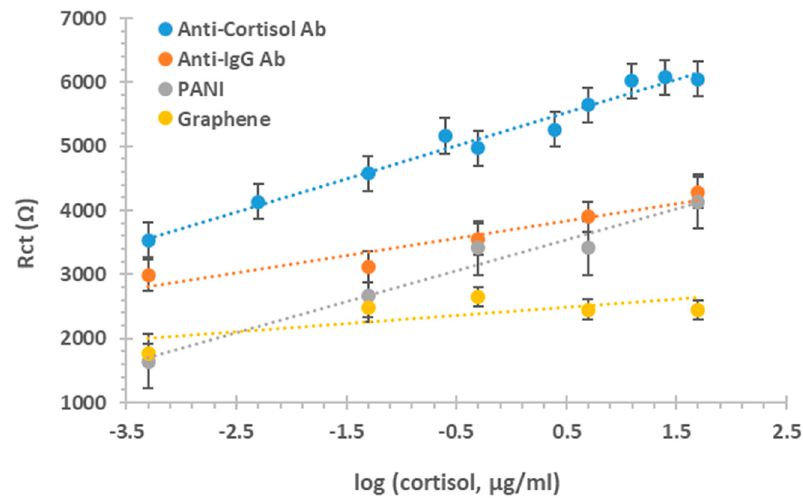
Figure 5. Controls. Calibration curve of Rct values for the different cortisol concentrations in the presence of anti-cortisol antibody (anti cortisol Ab); anti IgG antibody (anti IgG Ab); PANI layer (PANI) and graphene layer (Graphene).